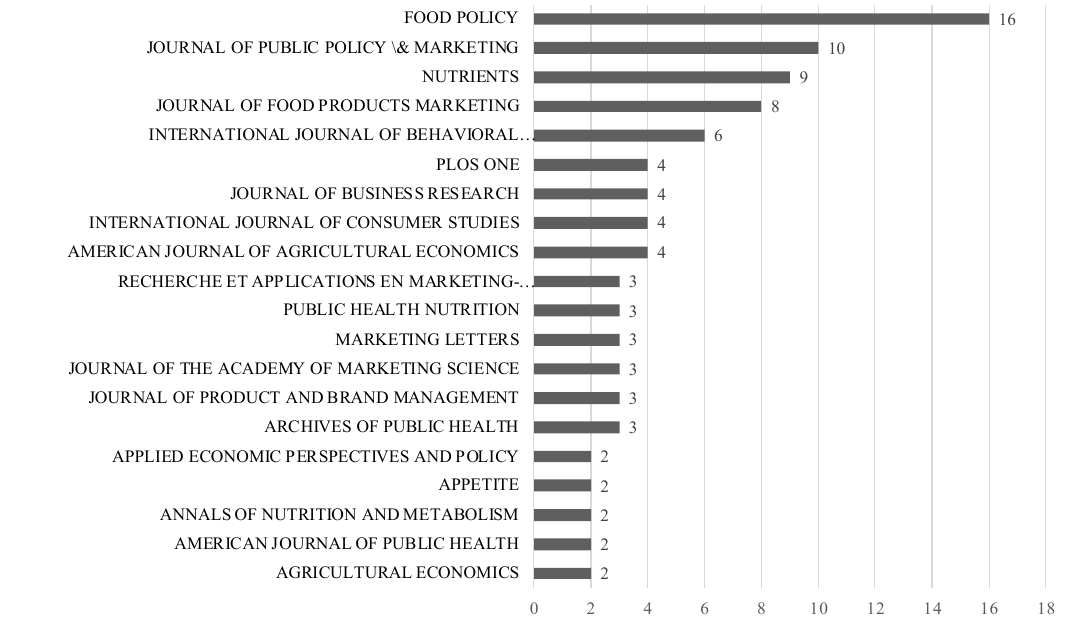
Figure 6. The most-cited sources.